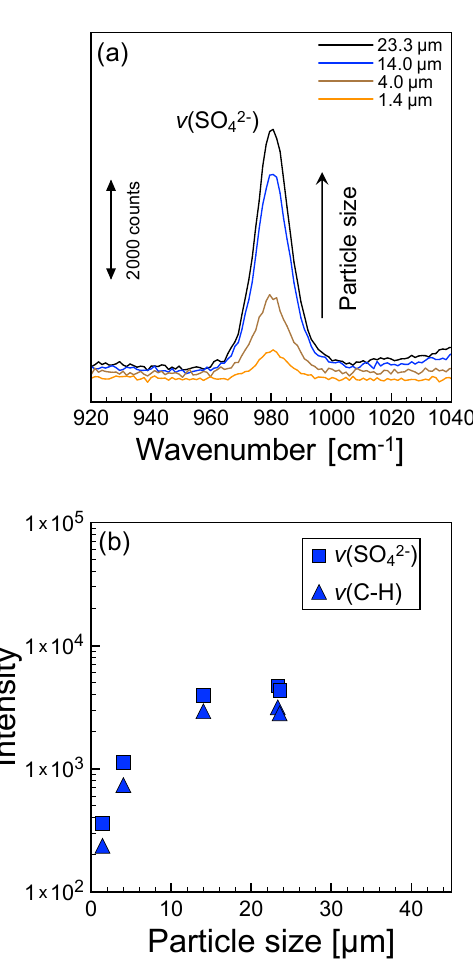
Figure 7. (a) Normal Raman spectra of the AS / sucrose particles as a function of particle size in the lower energy region (920– 1040cm − 1 ). The peak band is assigned to the v (SO 2 − (b) Raman intensity as a function of particle size for the v (SO 2 − and v (C–H)